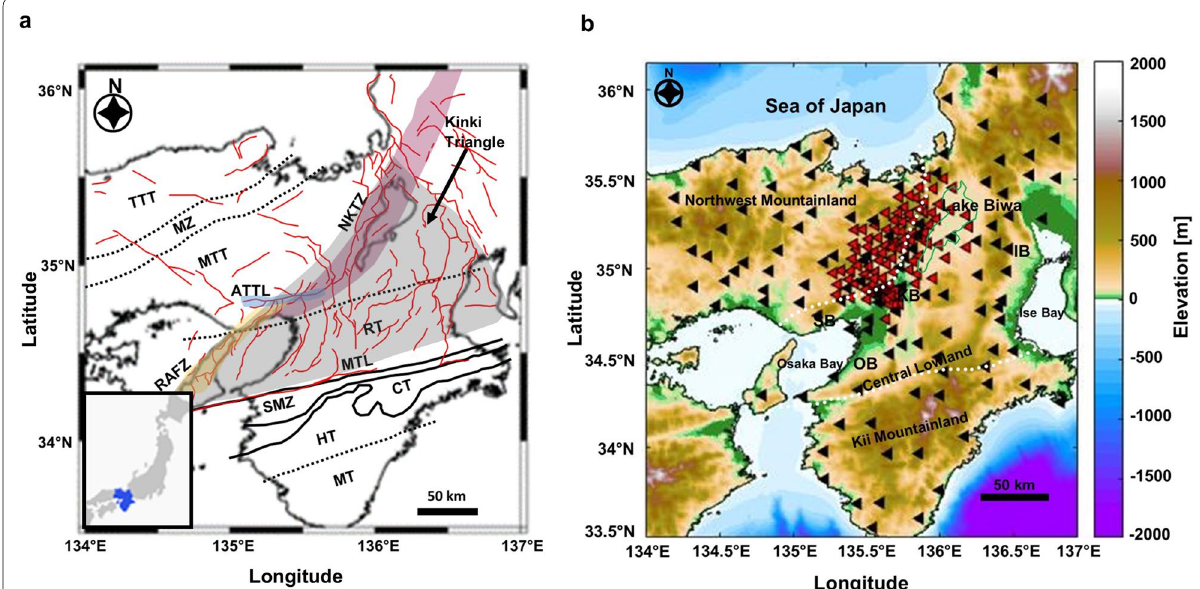
Fig. 1 a Map of the Kinki region showing the spatial distribution of tectonic structures. Red lines represent active faults (GSJ-AIST 2021), thick purple, yellow, and light blue lines represent the Niigata–Kobe Tectonic Zone (NKTZ), Rokko Active Fault Zone (RAFZ), and the Arima-Takatsuki Tectonic Line (ATTL), respectively. Also shown are the locations of the Median Tectonic Line (MTL), and tectonic divisions of the Kinki region, comprising Tango-Tajima Terrain (TTT), Maizuru Zone (MZ), Mino-Tamba Terrain (MTT), Ryoke Terrain (RT), Sanbagawa Metamorphic Zone (SMZ), Chichibu Terrain (CT), Hidaka Terrain (HT), and Muro Terrain (MT). The insert shows the location of the Kinki region within Japan. b Topographic map of the Kinki region. Black and red triangles indicate the locations of permanent and temporary stations, respectively. White, broken lines indicate the boundaries between the Northwestern Mountainland, Central Lowland, and Kii